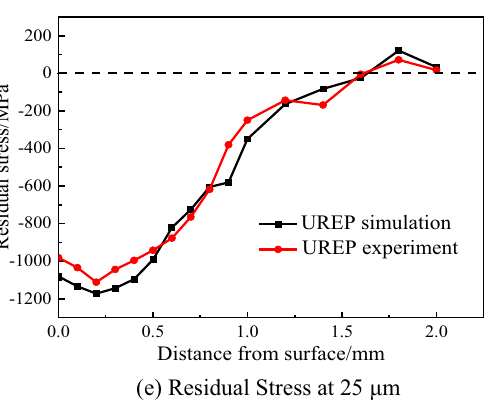
Figure 9. Residual stress of UREP at different